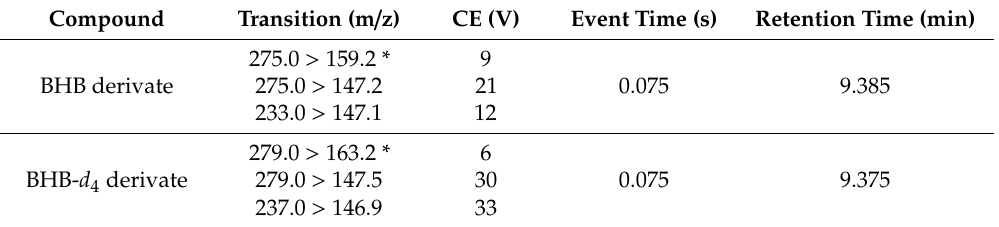
Table 1. Multiple reaction monitoring conditions used in the GC-MS analyses of β -hydroxybutyric acid (BHB) and internal standard derivates. Compound Transition (m / z) CE (V) Event Time (s) Retention Time